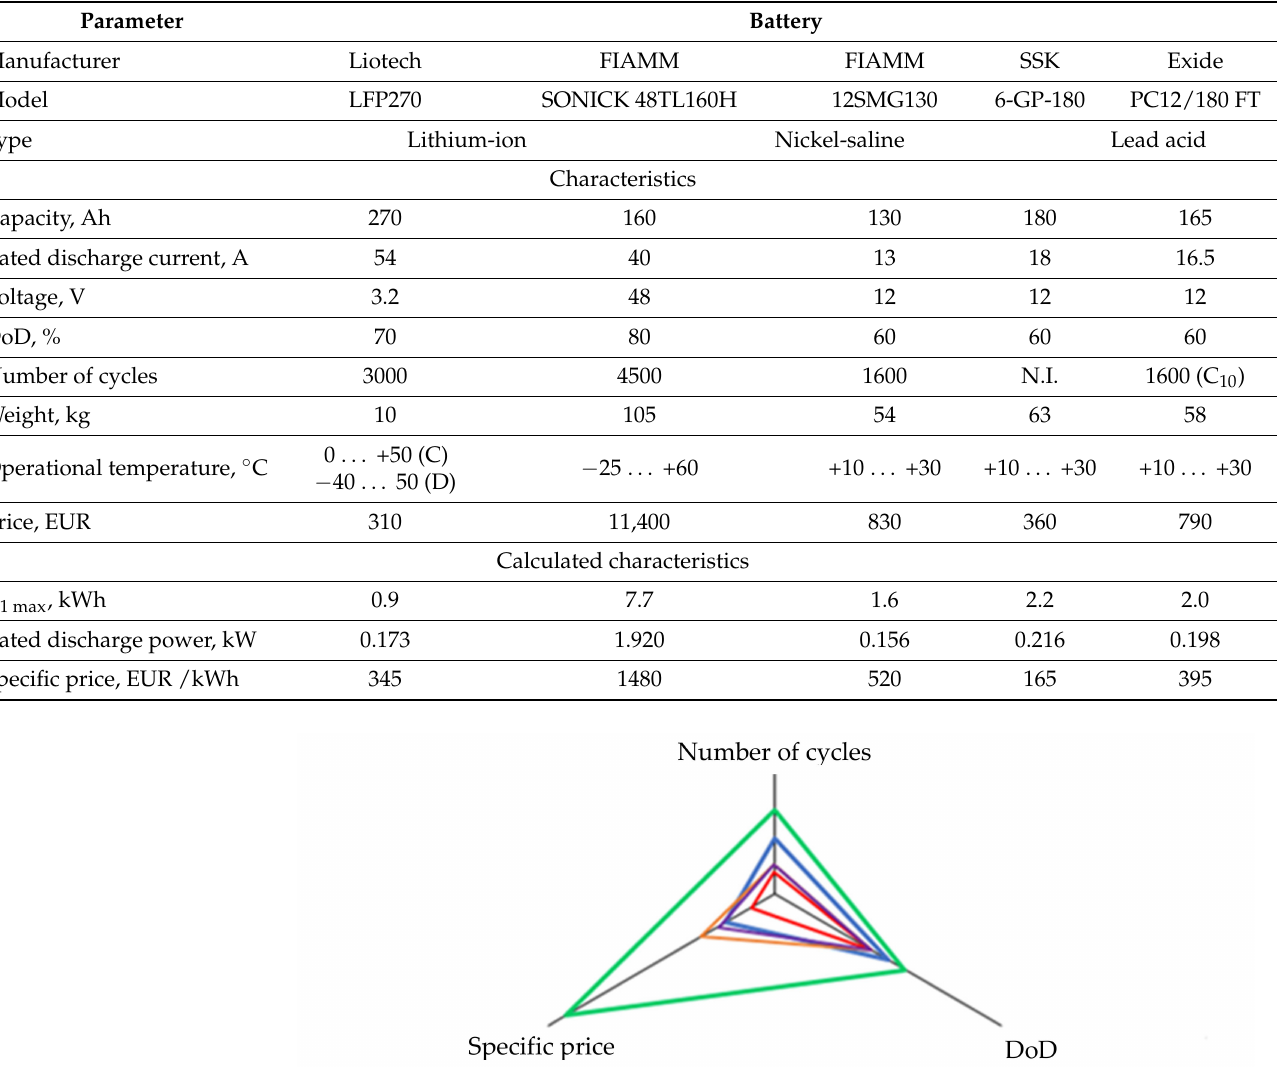
Table 3. The main characteristics of some batteries.